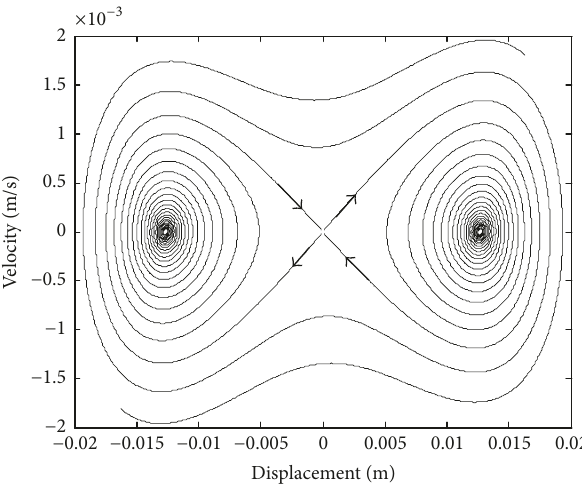
Figure 3: Numerical simulation for region (I), for ( 𝐾 1 , 𝐾 2 ) = (0.02, 0.01).